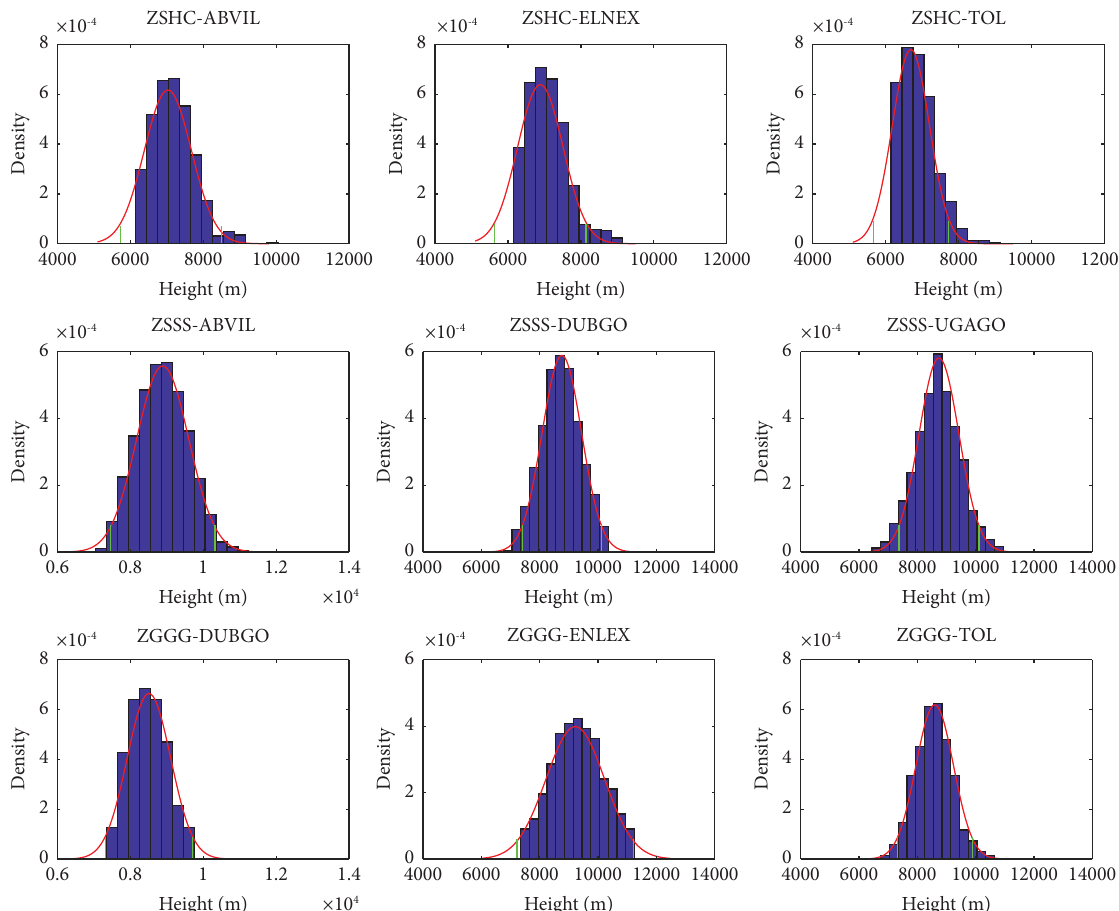
Figure 9: Height distribution of diferent waypoints from diferent airports to Shanghai sector 01.